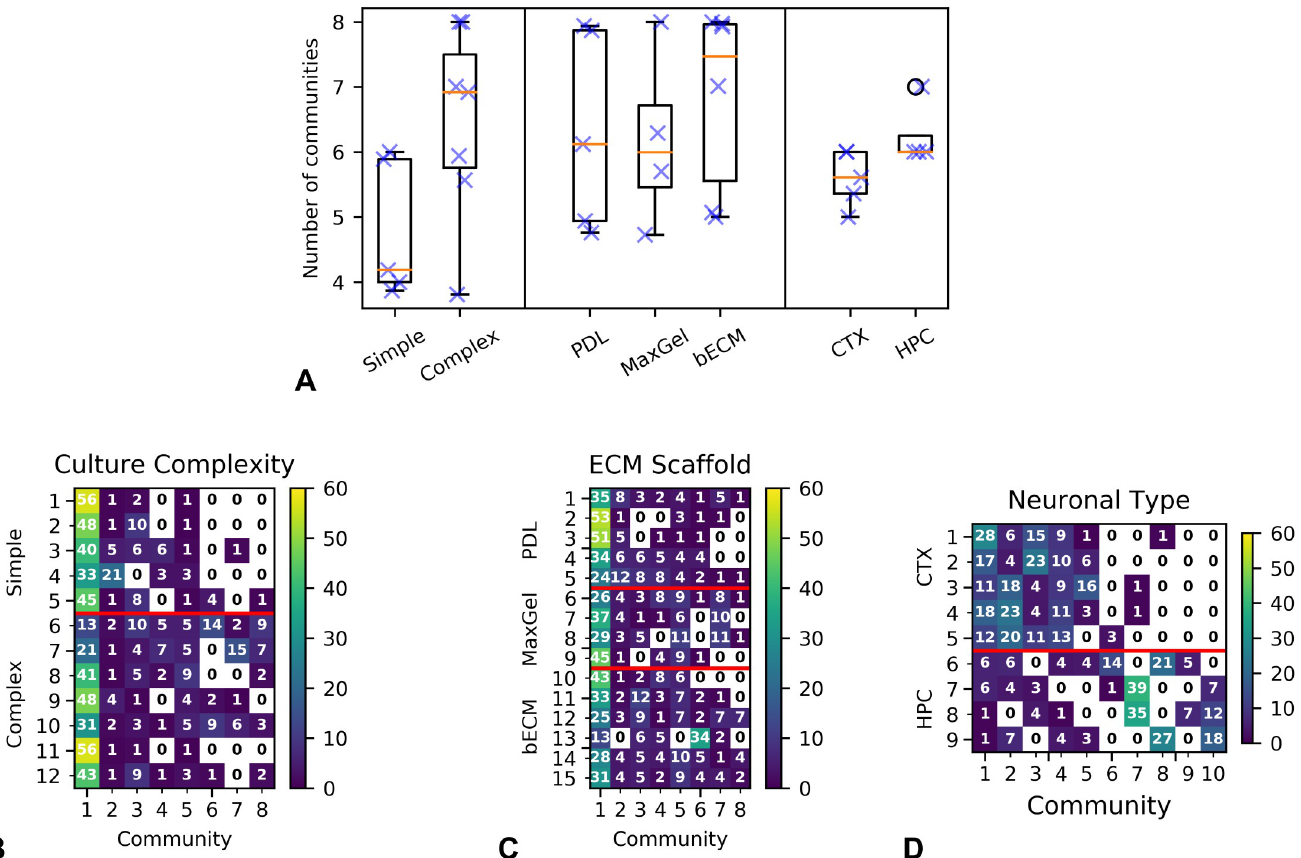
Fig 6. (A) Number of communities inferred by the model for the different experimental conditions—blue crosses correspond to individual MEAs. Community density in each device in the (B) Culture Complexity, (C) Extracellular Matrix, and (D) Neuronal Type datasets. White cells represent empty communities. We observed differences in community assignment when adding glial cells to simple cultures (B) or changing the cell type (D), but not from changing the ECM coating (C). See text for Discussion.